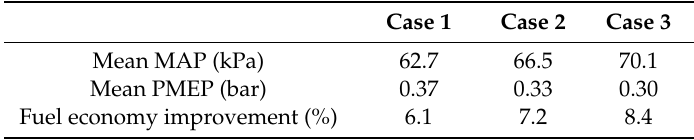
Table 7. Fuel economy improvement in FTP-75 of each